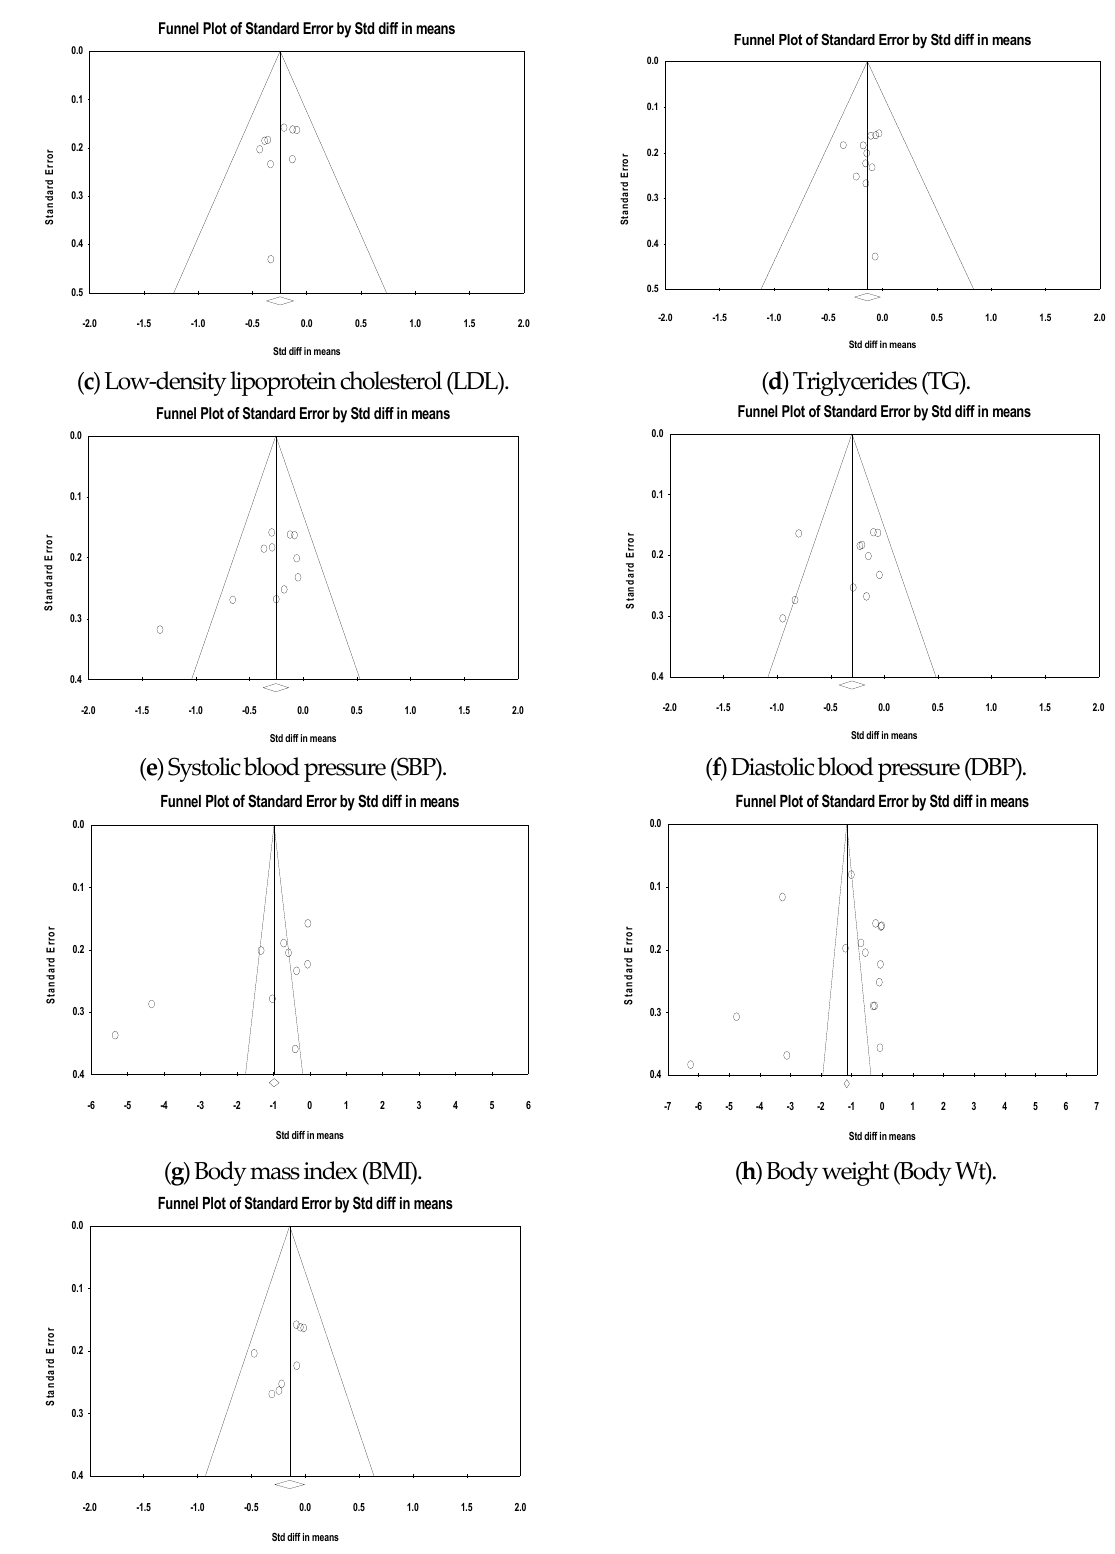
Figure 4. Funnel plot of the effects of the technology-mediated MetS intervention. ( a ) Waist circumference (WC), ( b ) High- density lipoprotein cholesterol (HDL), ( c ) Low-density lipoprotein cholesterol (LDL), ( d ) Triglycerides (TG), ( e ) Systolic blood pressure (SBP), ( f ) Diastolic blood pressure (DBP), ( g ) Body mass index (BMI), ( h ) Body weight (Body Wt), ( i ) Fasting glucose (FG).